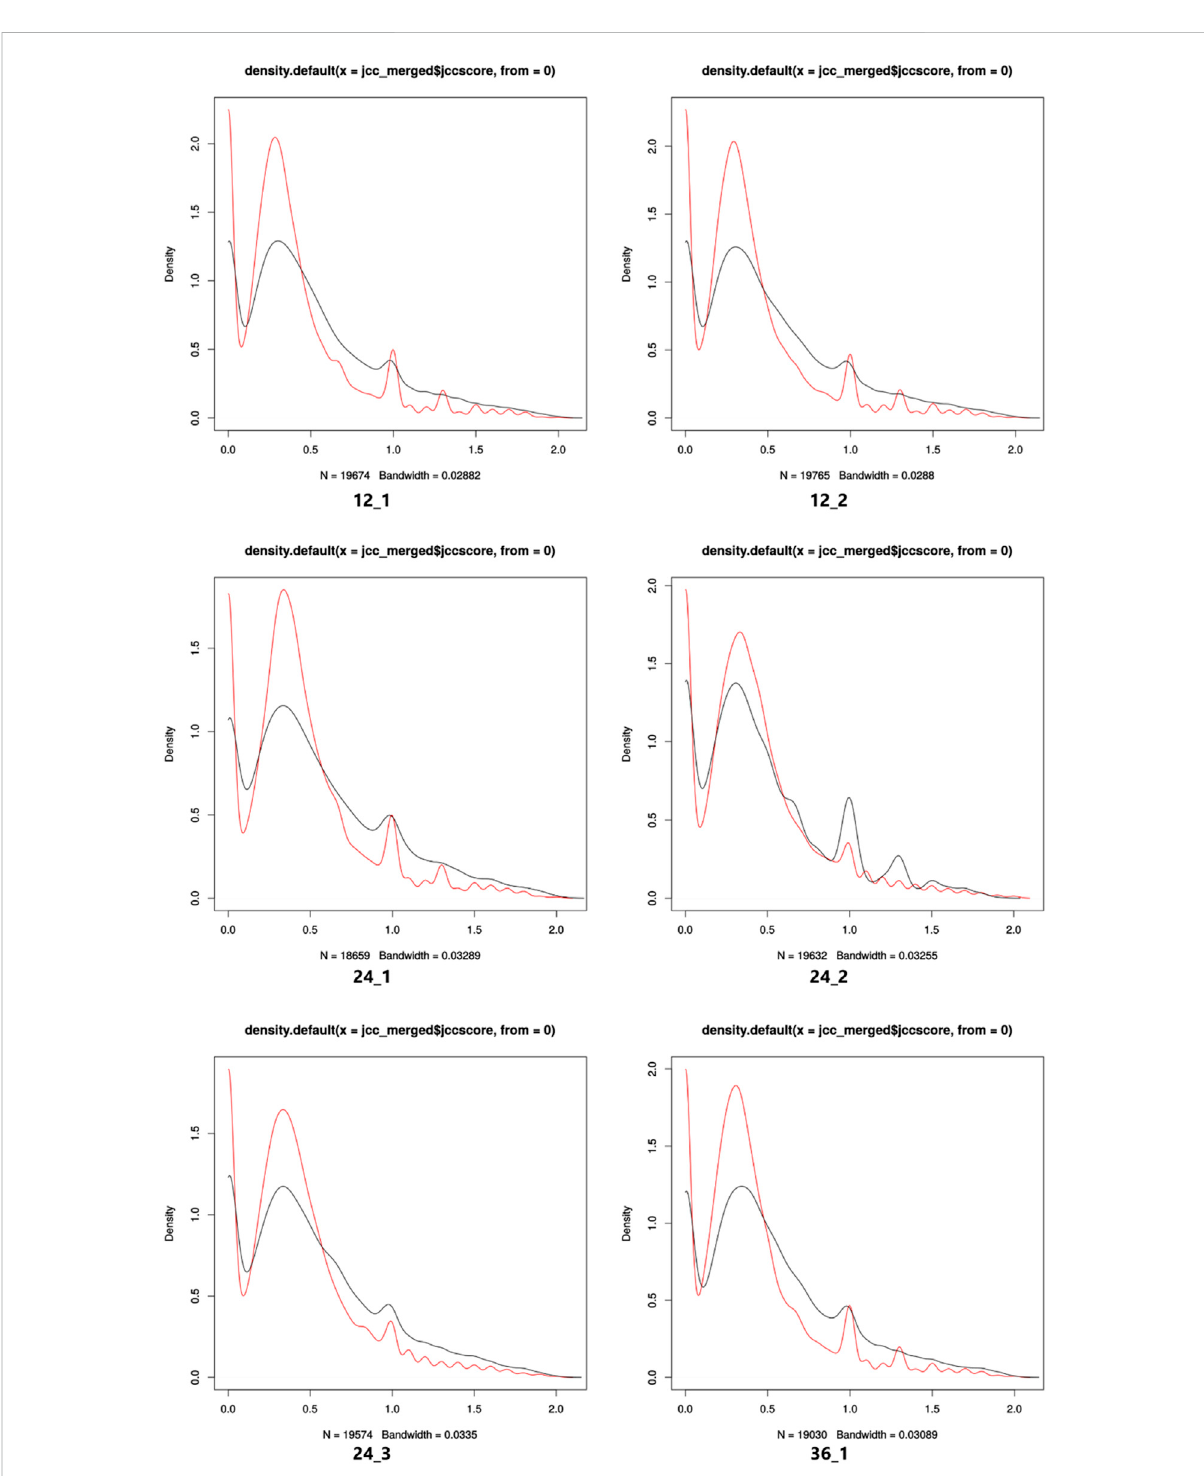
FIGURE 2 Density plots of the JCC scores of IndicaRTD (red line) and Ensembl RTD (black line) genes for each sequencing library. A comparison of the distribution of genes with JCC scores for both IndicaRTD and Ensembl RTD annotation for 12_1, 12_2, 24_1, 24_2, 24_3, and 36_1 sequencing libraries are shown. The X - and Y -axis represent the JCC score and gene density,